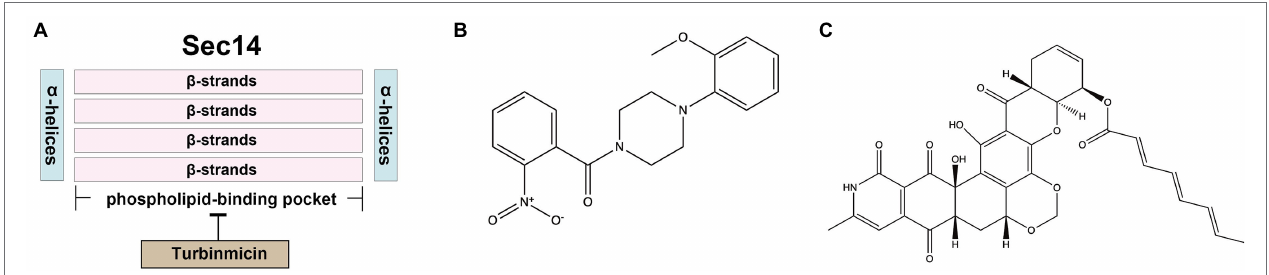
FIGURE 5 | (A) The docking model of Turbinmicin and Sec14; (B) structure of Sec14 inhibitors NPPMs; and (C) structure of Sec14 inhibitor